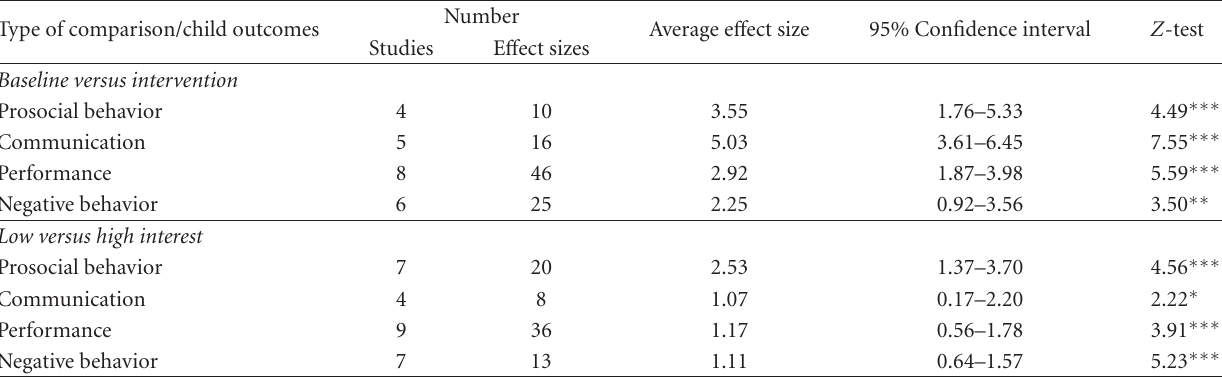
Table 2: Average e ff ect sizes and 95% confidence intervals for the di ff erent categories of child outcomes. Number Type of comparison/child outcomes Average e ff ect size 95% Confidence